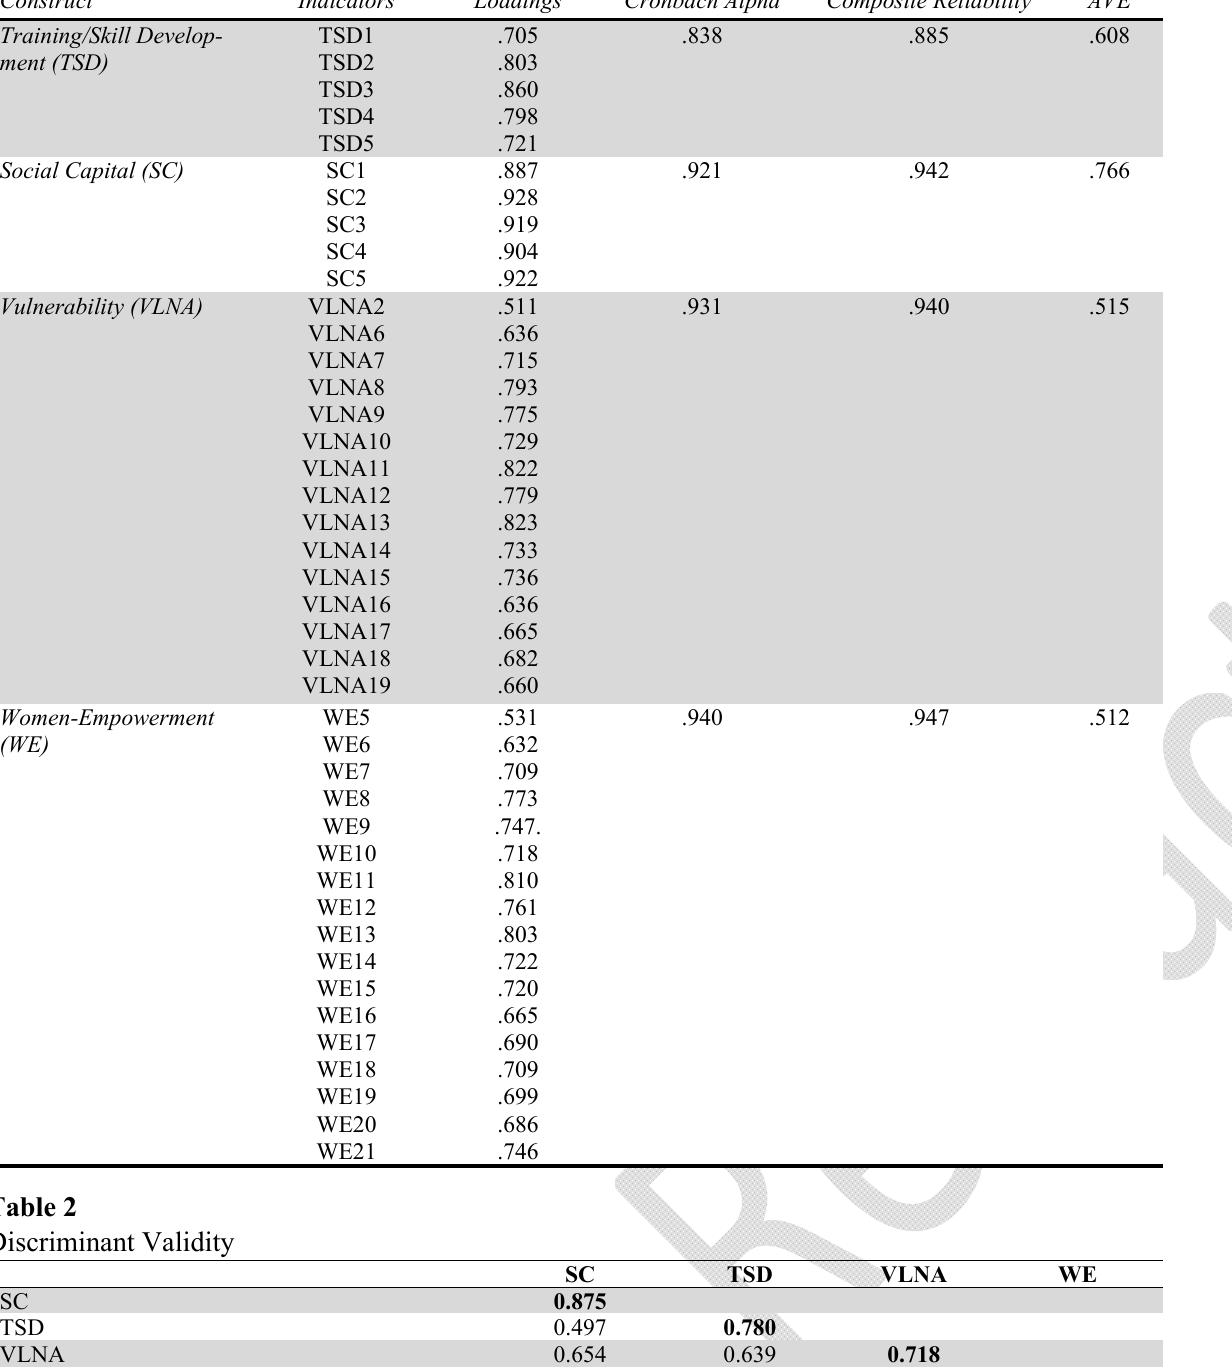
Internal Consistency, Convergent Validity and Average Variance Extracted (AVE) Construct Indicators Training/Skill